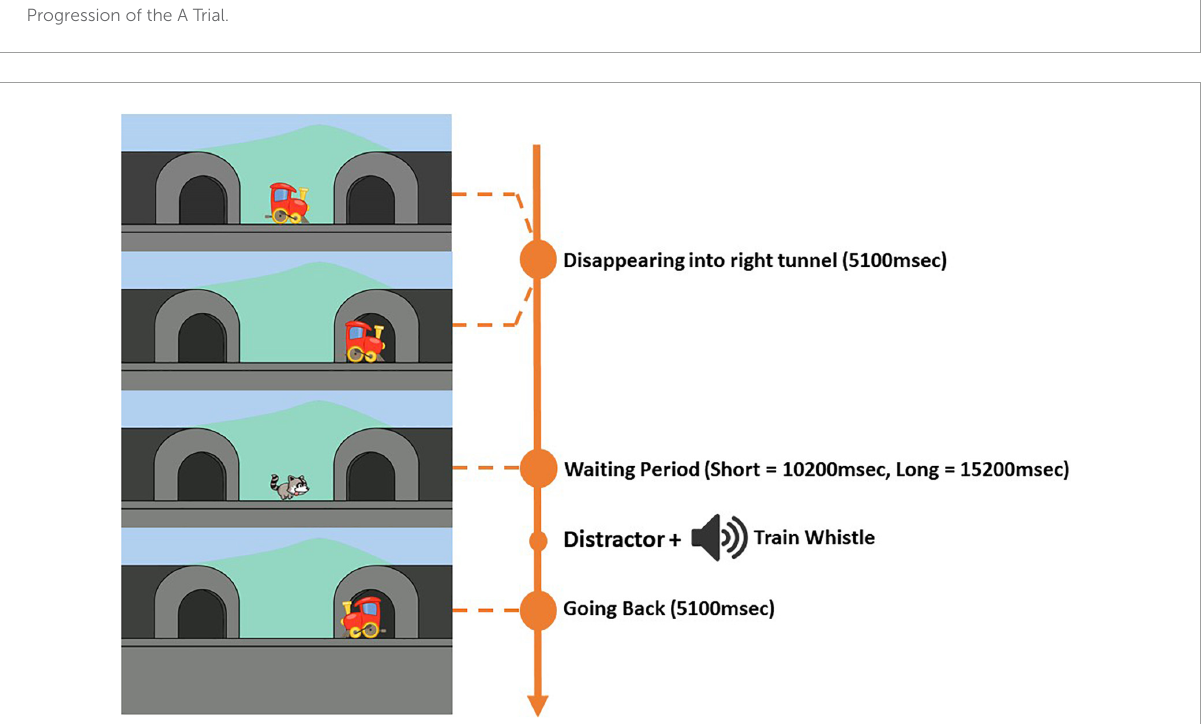
FIGURE2 Progression of the B Trials with short (10,200 ms) and long (15,200 ms) waiting periods.